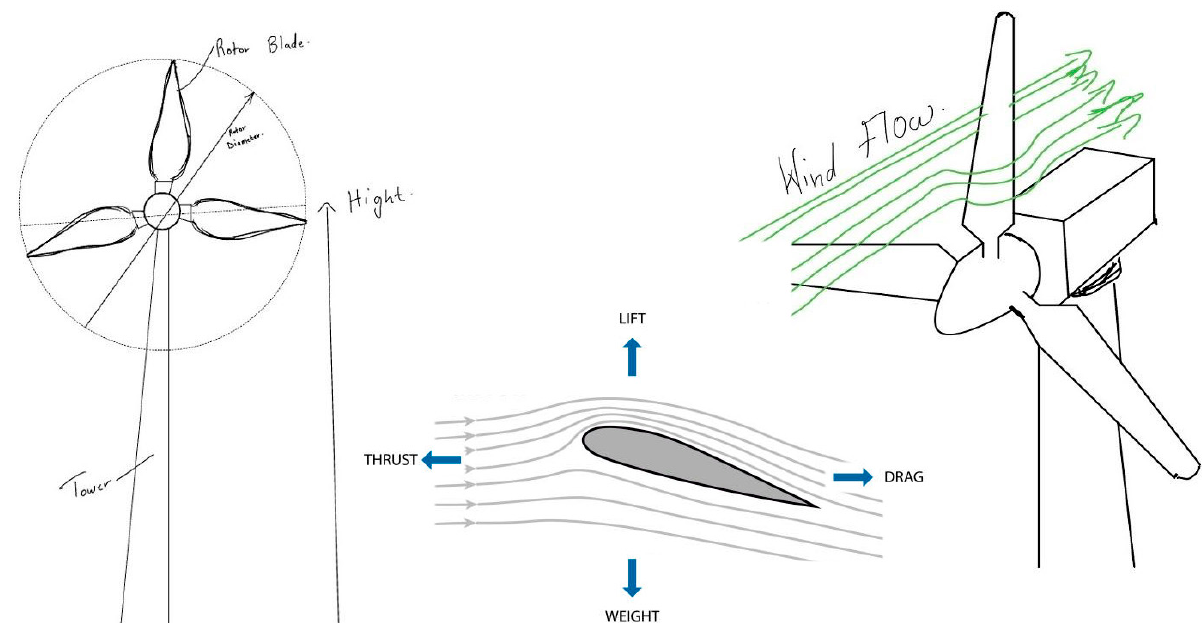
Figure 13. Typical horizontal axis wind turbine (HAWT) [25].